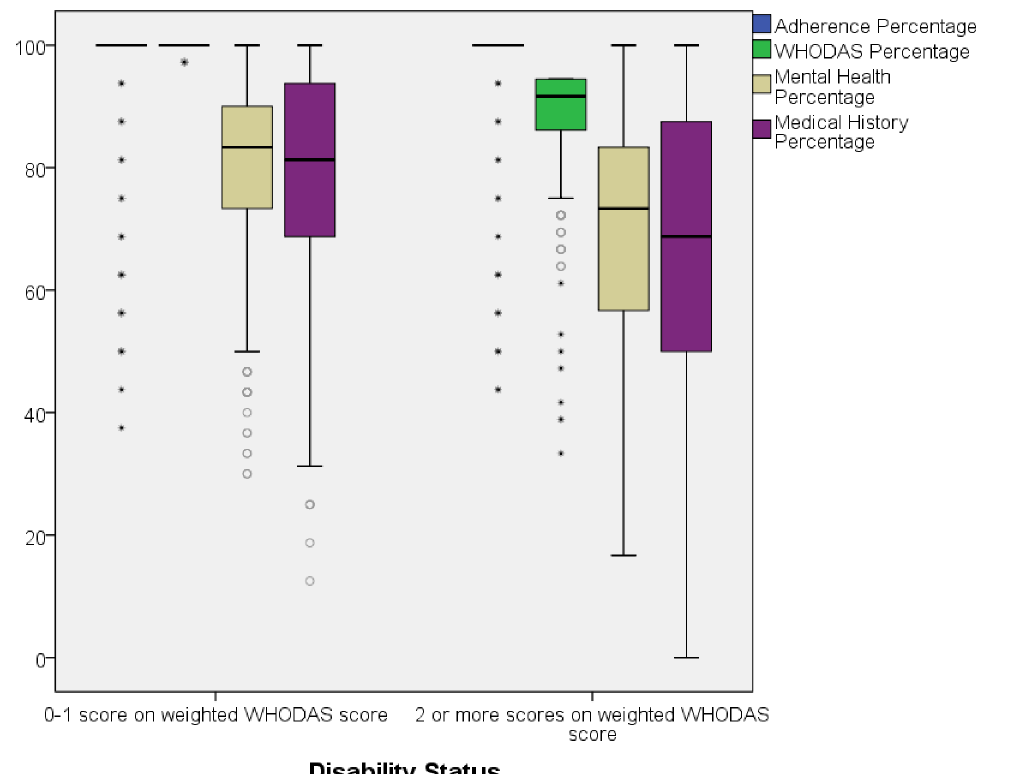
Fig 3. Boxplot of converted health scores in percentages split by disability status.